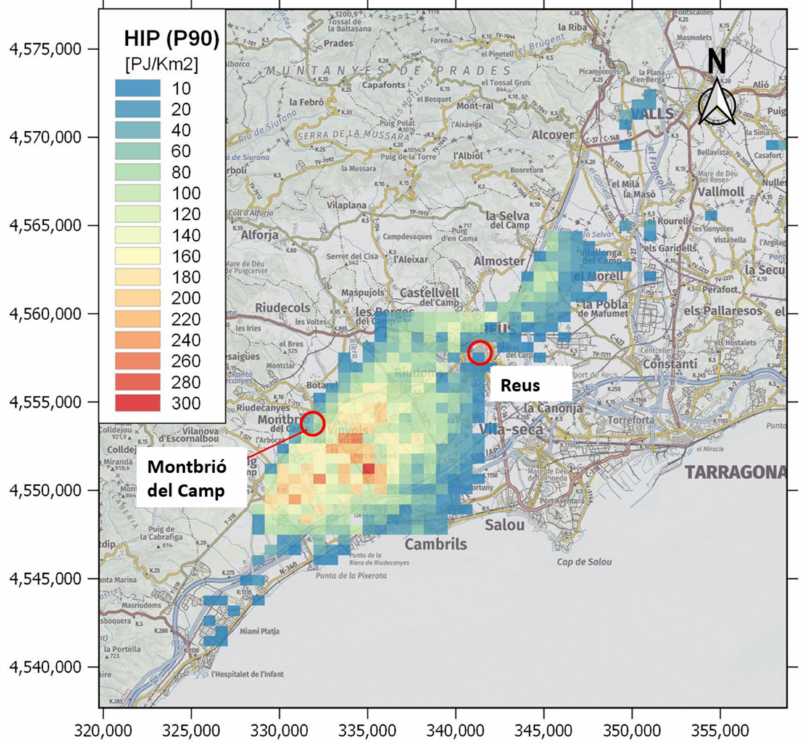
Figure 11. 2D georeferenced map showing the HIP results obtained using example 3. The resulting HIP (P90) values are divided by the voxel area to express the results in PJ/km 2 . Only on-shore values are